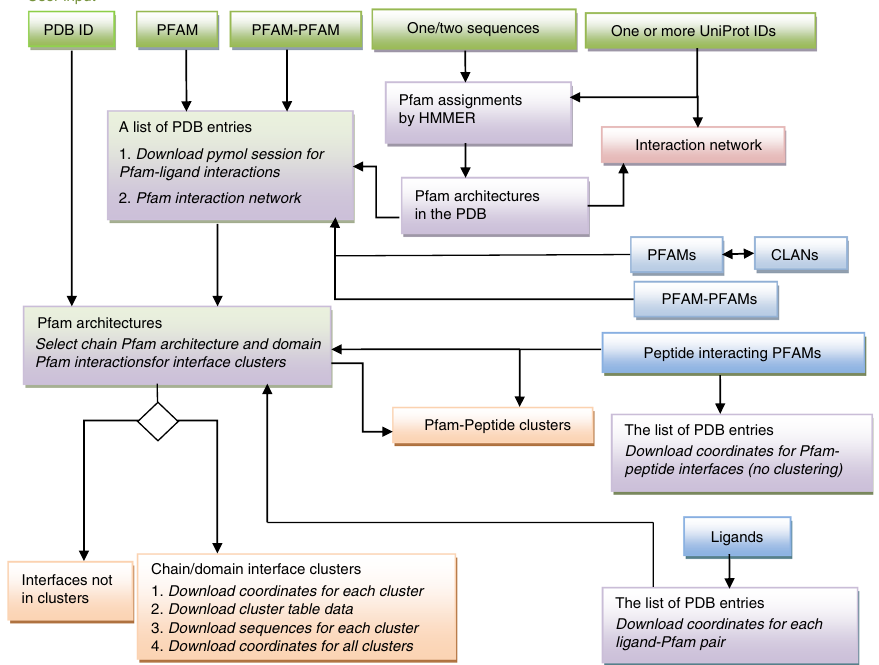
Fig. 1 The infrastructure of the ProtCID web site. There are four types of queries that can be input by users: a PDB ID; one or two Pfam IDs; one or two sequences; and one or more UniProt IDs. The user can also browse all available Pfam IDs, Clan IDs, Pfam – Pfam pairs, peptide-interacting Pfams, and ligands. A Pfam page provides a list of PDB structures containing the Pfam. Clicking on one structure leads to the same page as querying by that PDB ID, which shows the Pfam architecture of the entry. From the PDB entry page, a user can select and display interface clusters: chain – chain interfaces, domain – domain interfaces, as well as domain – peptide interfaces. The coordinates of different interactions and clusters can be downloaded from the Pfam pages and the cluster